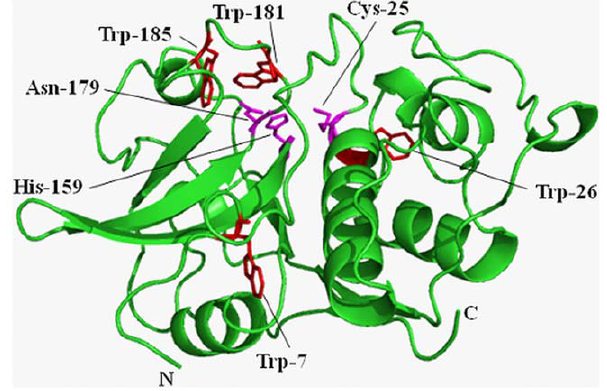
Figure 1. Ribbon structure of chymopapain (1YAL) as drawn by PyMol. Position of Trp and active site residues is shown. doi:10.1371/journal.pone.0050633.g001 PLOS ONE |